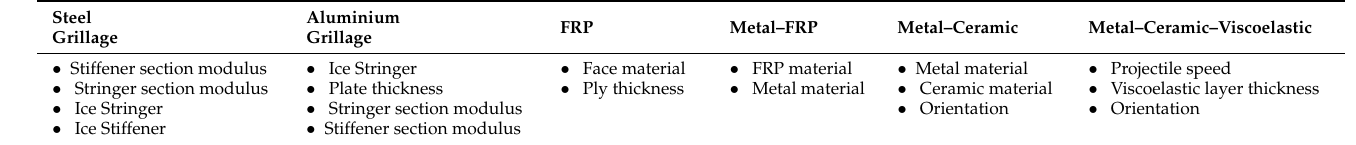
Table 7. Significant parameters for respective structural concepts arranged in descending order.